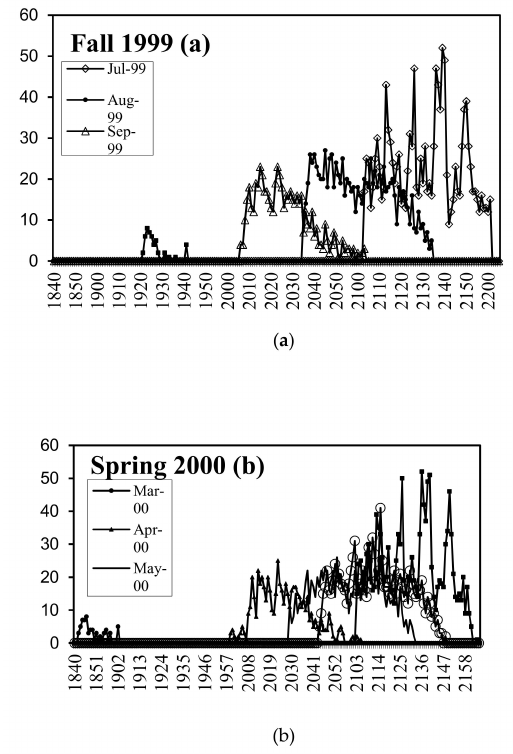
Figure 1. Emergence patterns in the Fall of 1999 ( a ) and Spring of 2000 ( b ) showing the shift in emergence times in response to season and the increase in emergence size throughout the summer. Numbers on the Y-axis are individuals counted in one-second intervals / minute throughout the emergence. Note that July data were collected on both seasons, and the pattern is highly consistent from year to